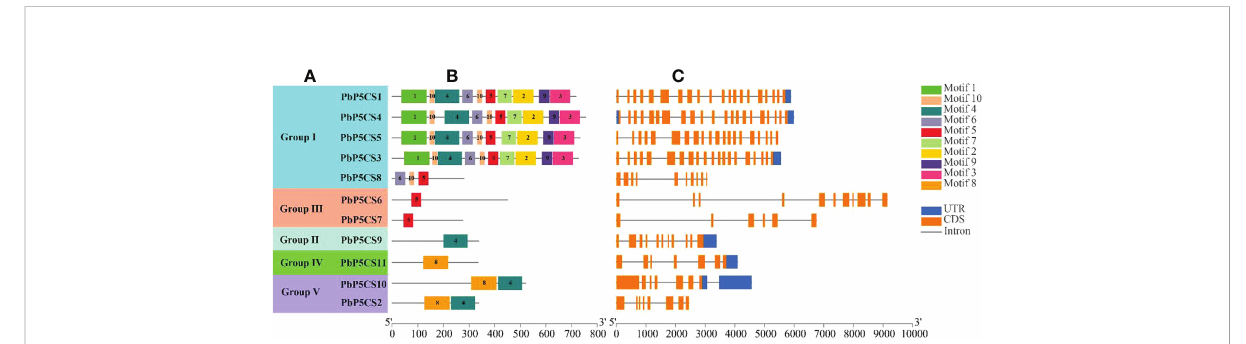
FIGURE 2 Schematic representation of protein and gene structures of pear P5CS ( PbP5Cs ) genes. (A) Phylogenetic relationships. (B) Motif composition. (C) Gene structure. Motifs 1 − 8 identi fi ed using the MEME search tool are marked on protein sequences in each clade (I − V). The length and order of each motif corresponds to the actual length and position in the protein sequences. Coding sequence and untranslated regions are represented by fi lled orange and dark blue boxes, respectively.